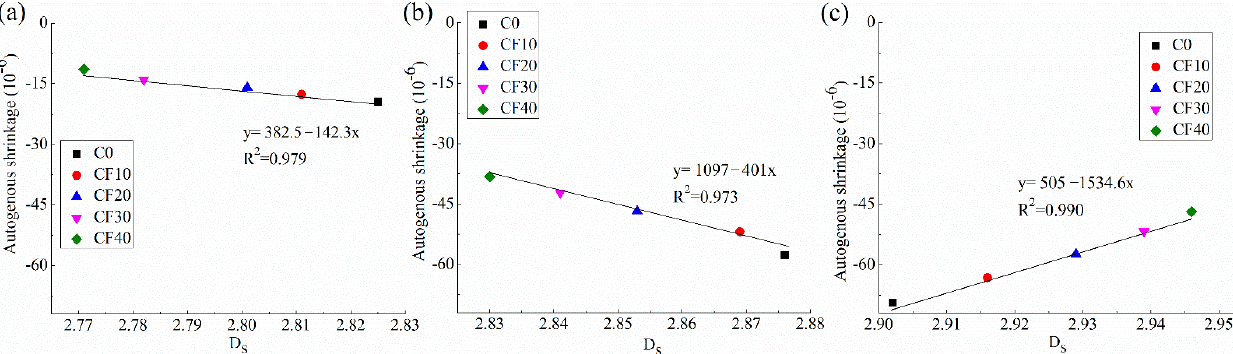
Figure 12. Correlations between autogenous shrinkage and D s at ( a ) 3 days, ( b ) 28 days and ( c ) 180 days.